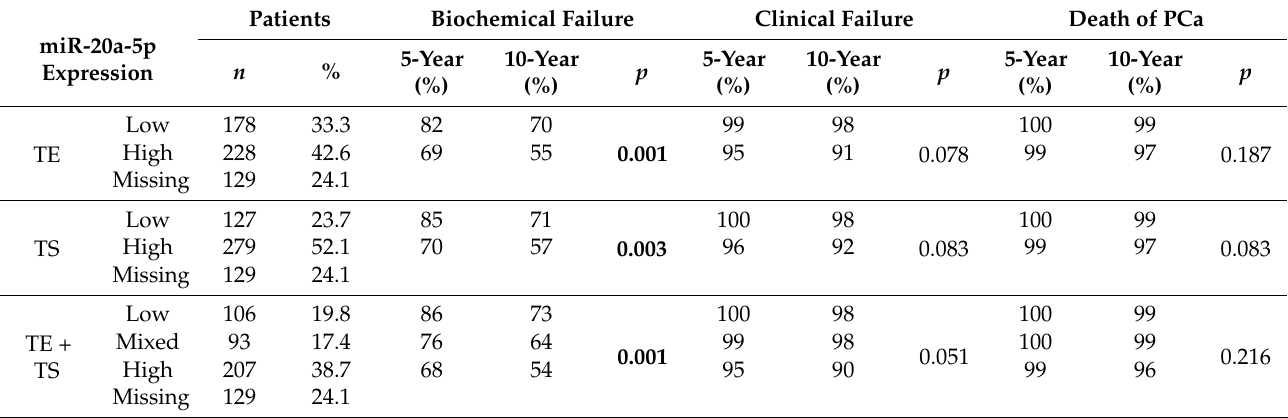
Table 2. Exploring miR-20a-5p impact as independent prognostic variable for BF. Multivariate analysis of miR-20a-5p expression and significant clinicopathological variables from the univariate analyses (Cox regression analyses, n = 535, backward conditional). Univariate analyses are in Table 1 and Supplementary Table S3. p -values below 0.05 marked in bold. Abbreviations: BF = biochemical failure; HR = hazard ratio; LVI = lympho-vascular infiltration; NE = not entered; NS = not significant; p = p -value; PCM = positive circumferent margin; PNI = perineural infiltration; TE = tumor epithelium; TS = tumor stroma.